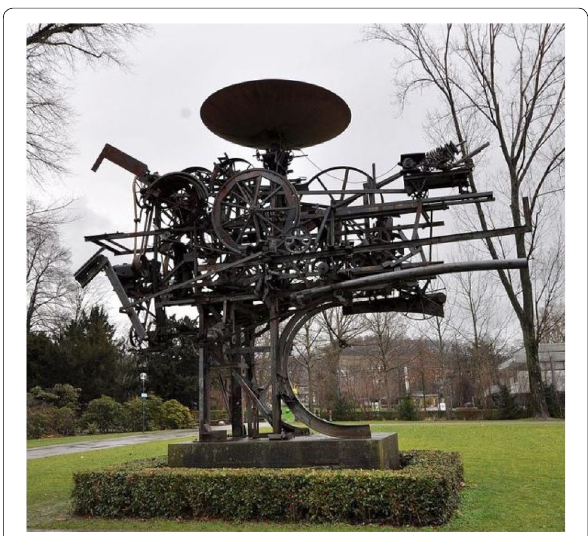
Fig. 1 Tinguelys Eureka machine. Source: https ://www.tofug u.com/ japan /chind ogu-japan ese-inven tions /